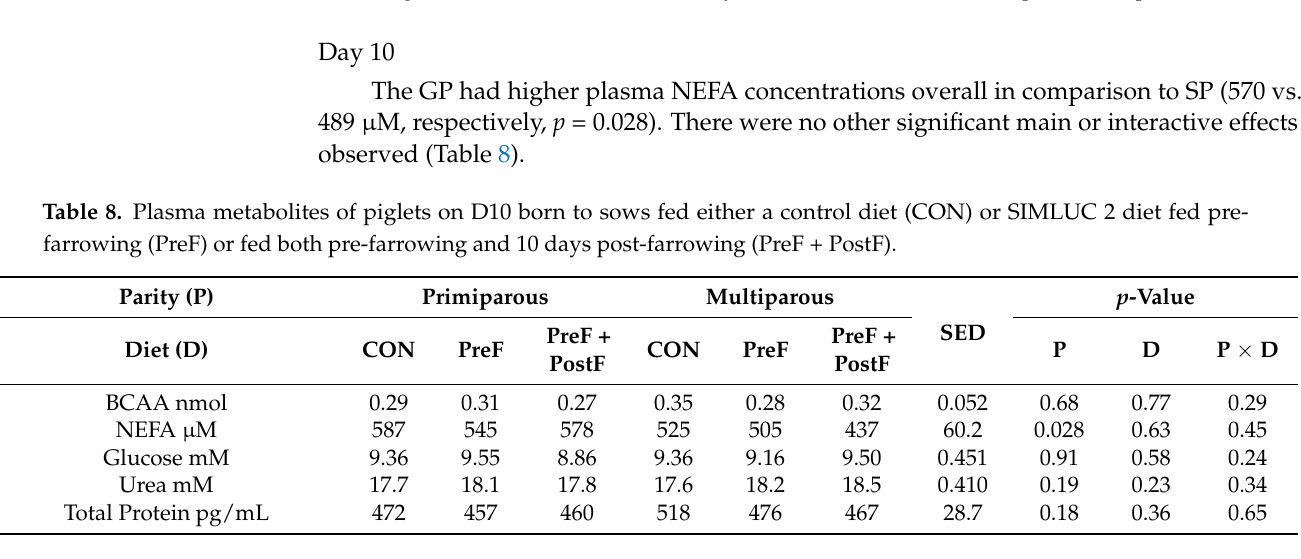
Table 7. Plasma metabolites of piglets on D1 born to sows fed either a control diet (CON) or the SIMLUC 2 diet. Parity (P) Primiparous Diet (D) BCAA nmol Glucose mM Total Protein pg/mL